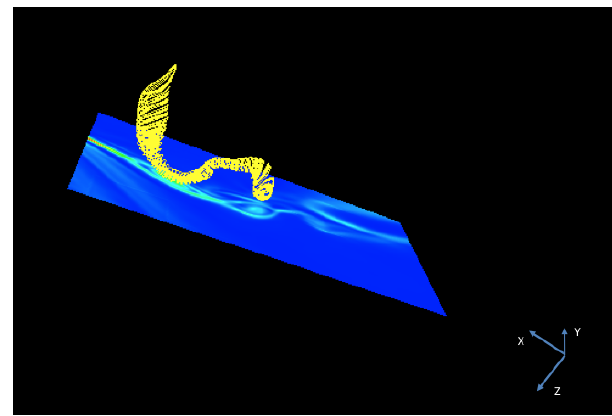
Figure 7. 3-D display of the FTE shown in Fig. 6. The solar mag- netic field lines of the flux transfer event on the X – Y plane are shown in the yellow